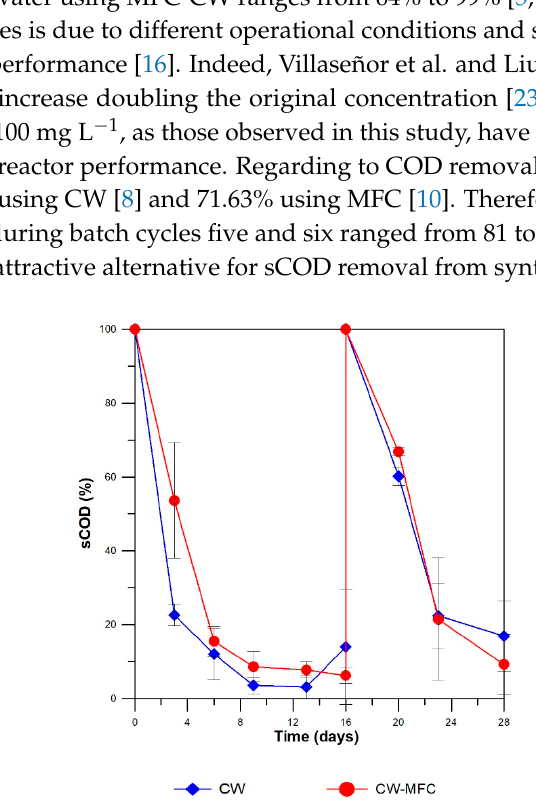
Figure 2. Mean percentage of soluble chemical oxygen demand (sCOD) within the CW (blue) and CW-MFC (red) reactors during batch 5 and 6. Error bars indicate the standard deviation calculated from six